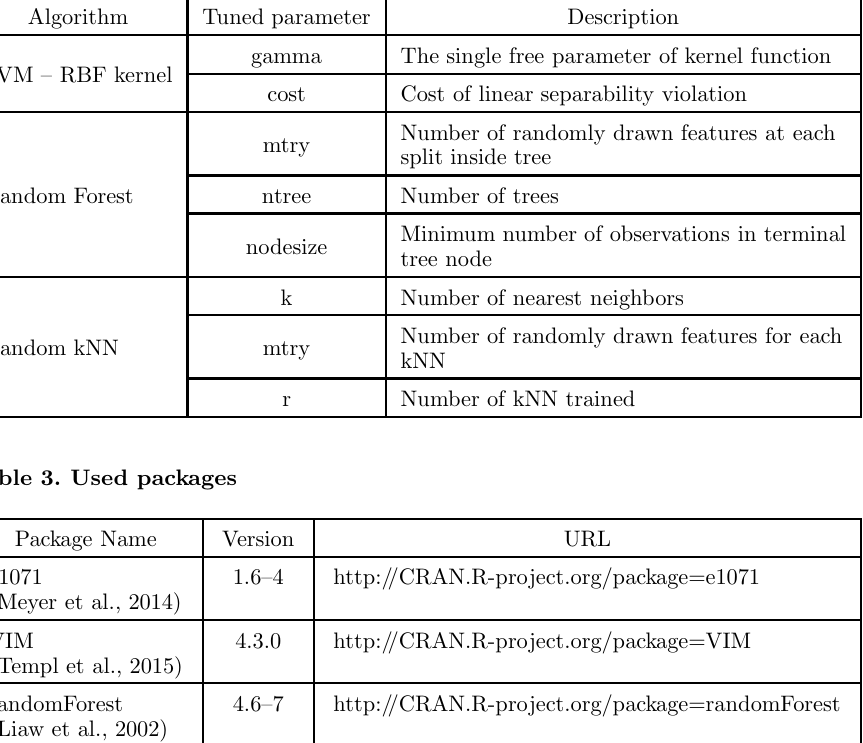
Table 2. Tuned parameters – classification algorithms Algorithm